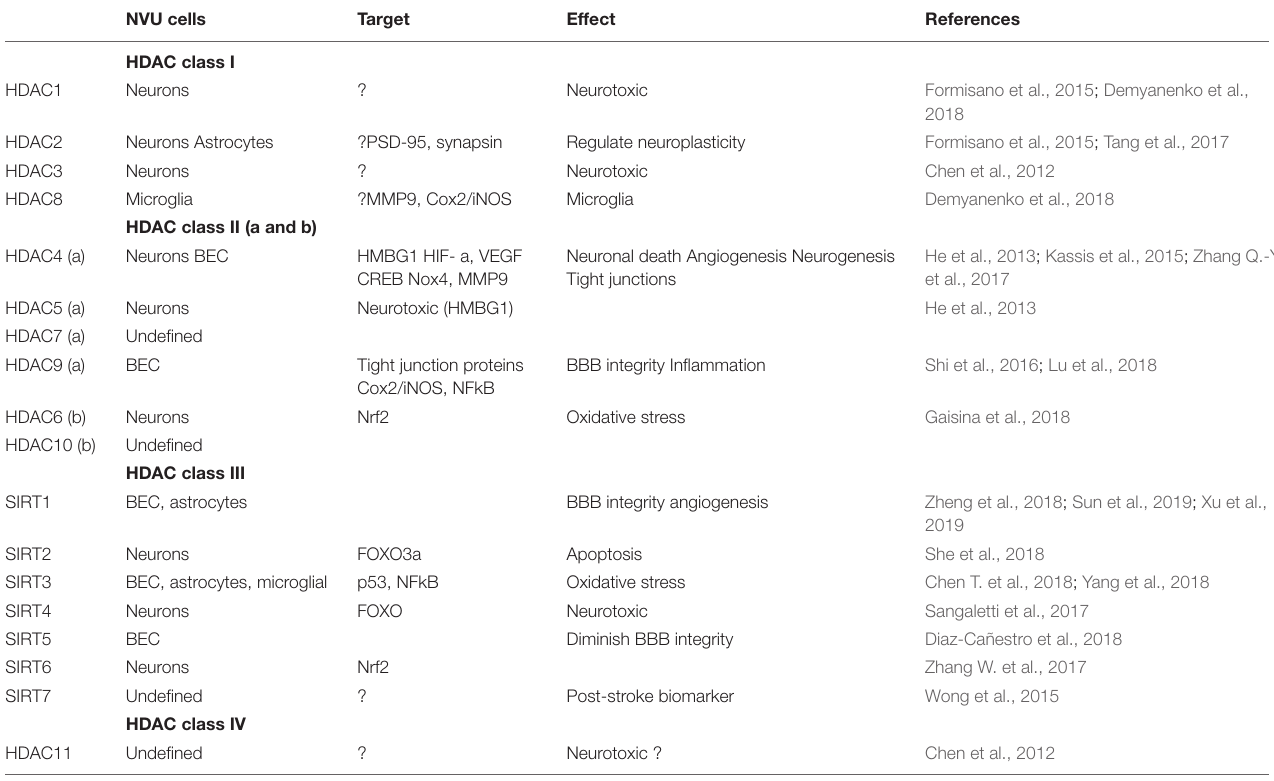
TABLE 1 | NVU HDAC cell expression profile and effect in post-stroke